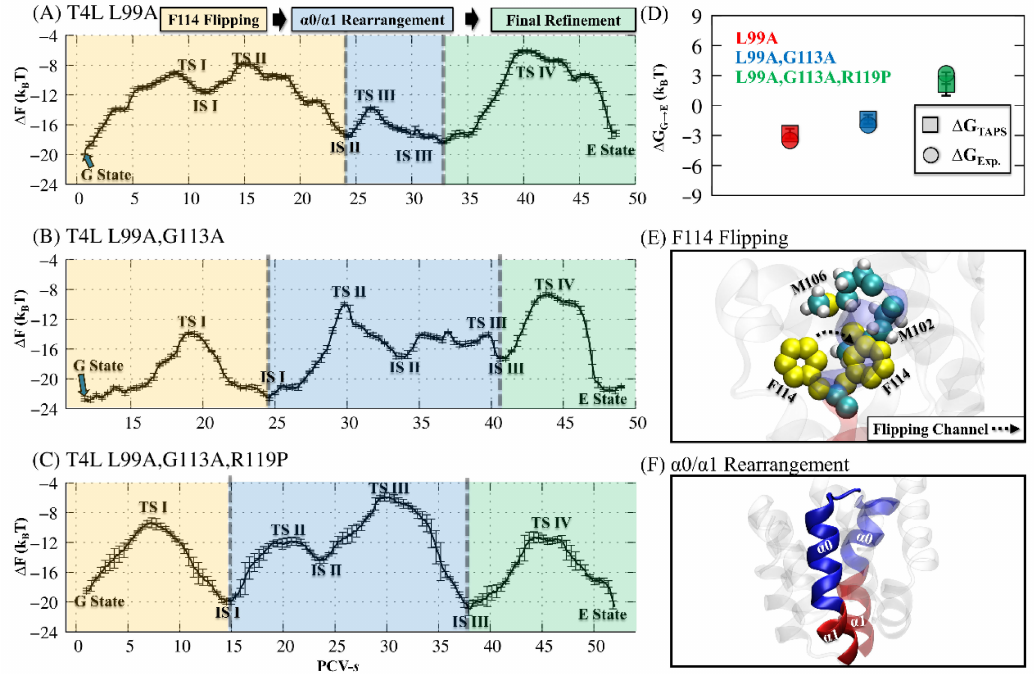
Figure 2. ( A – C ) The free energy landscapes revealed by umbrella sampling method [67–69] along the found MFEP for ( A ) T4L-L99A, ( B ) T4L-L99A,G113A, and ( C ) T4L-L99A,G113A,R119P. The important transition state (TS) and intermediate state (IS) are identified from the free energy landscape. The three main steps of the G/E interconversion are highlighted: F114 flipping (yellow), α 0/ α 1 rearrangement (blue), and final refinement (green). ( D ) The free-energy differences between G state and E state ( ∆ G G → E ) for T4L-L99A (red), T4L-L99A,G113A (blue), and T4L-L99A,G113A,R119P (green). The squares and circles are used to label ∆ G G → E from the TAPS and the experiment, respectively [20]. ( E ) Illustration of flipping of F114. ( F ) Illustration of the α 0(blue)/ α 1(red) rearrangement. All the structures are displayed by visual molecular dynamics (VMD)